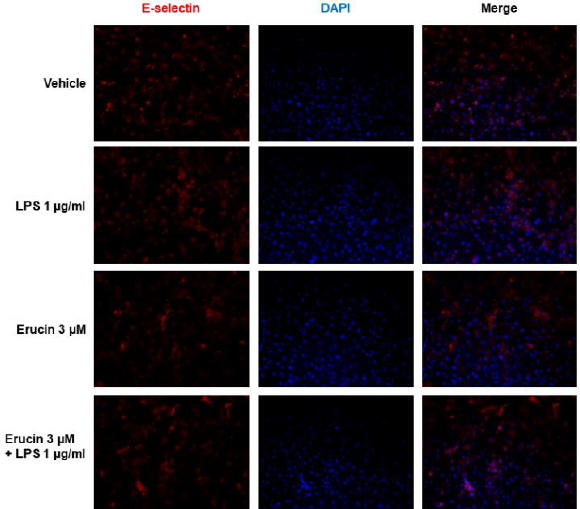
Figure A2. E-selectin localization in HUVEC evaluated by immunofluorescence. Cells were pre- treated with erucin (3 µM, 1 h) and then with LPS (1 µg/mL, 6 h). Images were obtained by confocal microscope (magnification 63×). Scale bar — 50 µm.